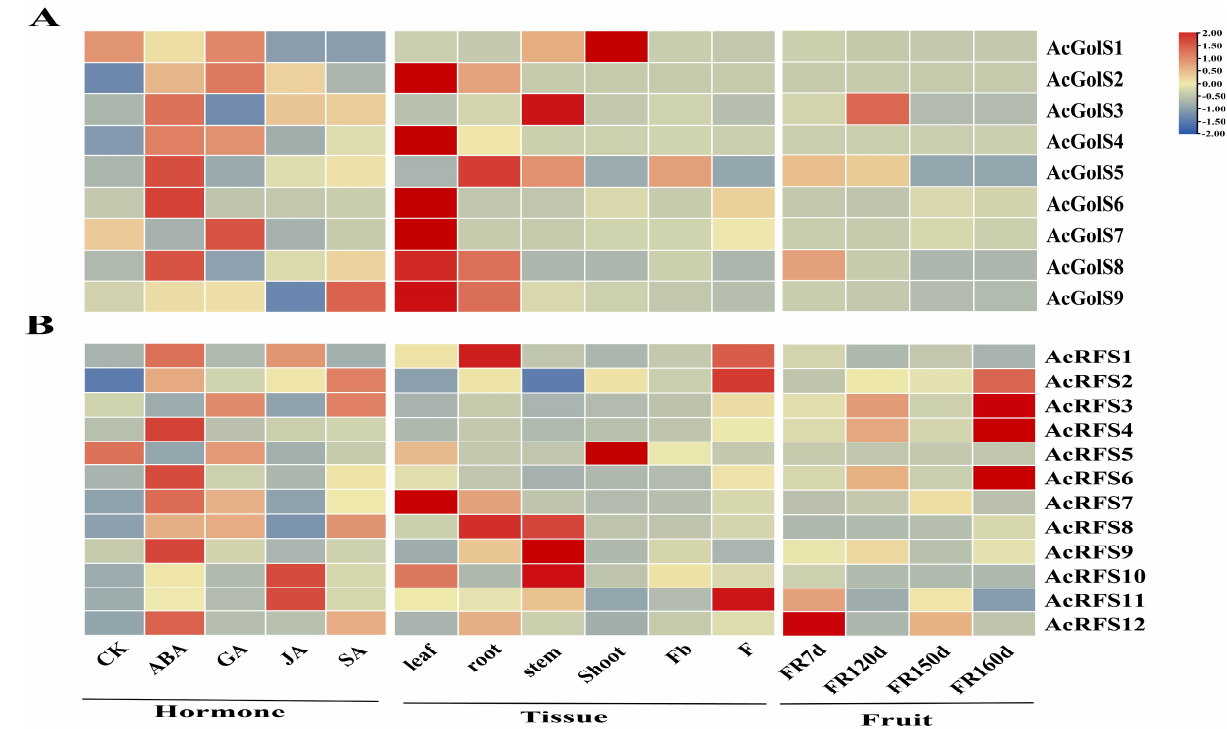
Figure 4. Hormone-induced conditions, tissue-specific and fruit development expression analysis of AcGolS and AcRFS genes in A. chinensis. ( A ) Expression profiles of AcGolS genes; ( B ) Expression profiles of AcRFS genes. The color bar to the right of the figures represents the log2 FPKM (fragments per kilobase of exon per million reads mapped) value.